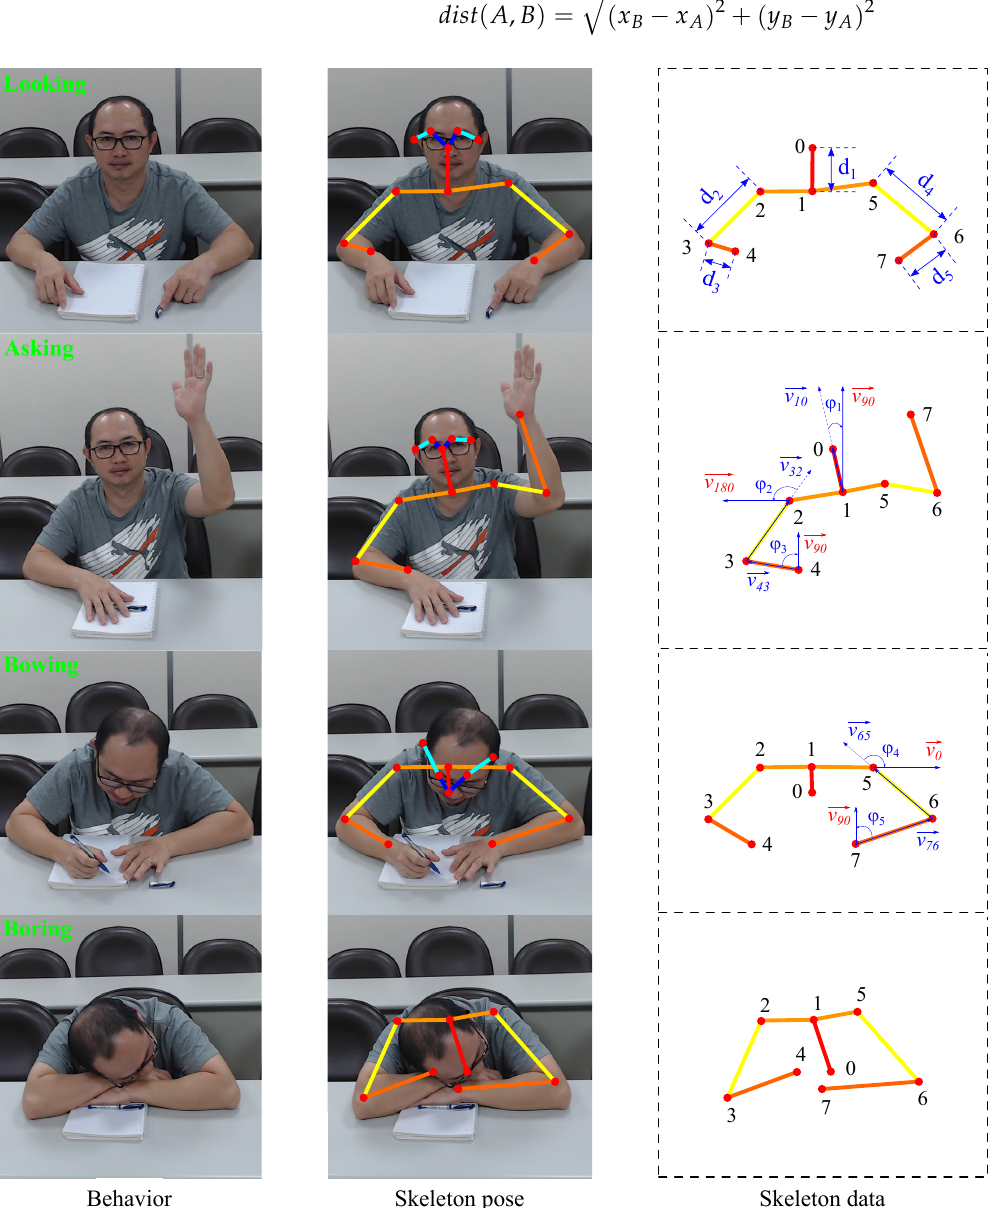
Figure 6. Analysis of the skeleton